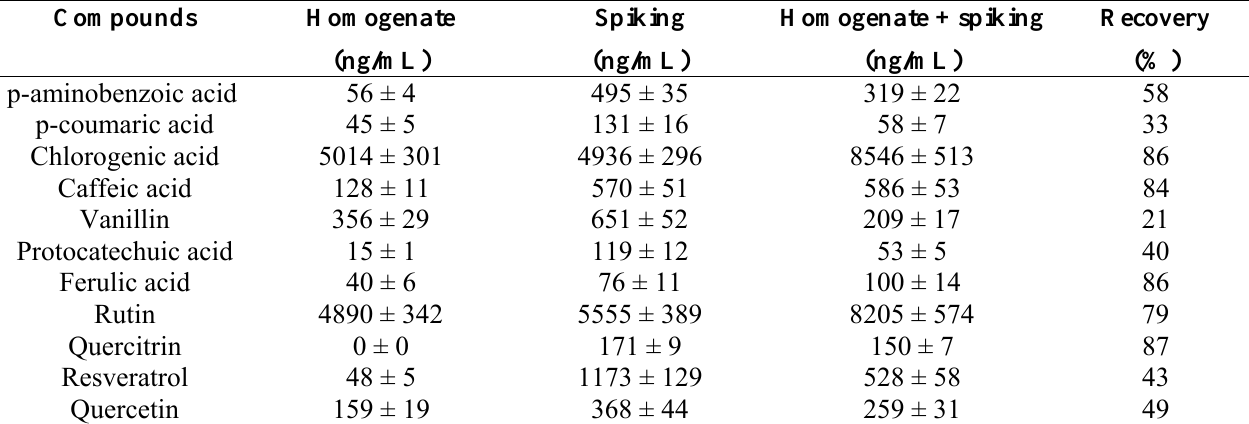
Table 3. Add Recovery of 20% Acetone.